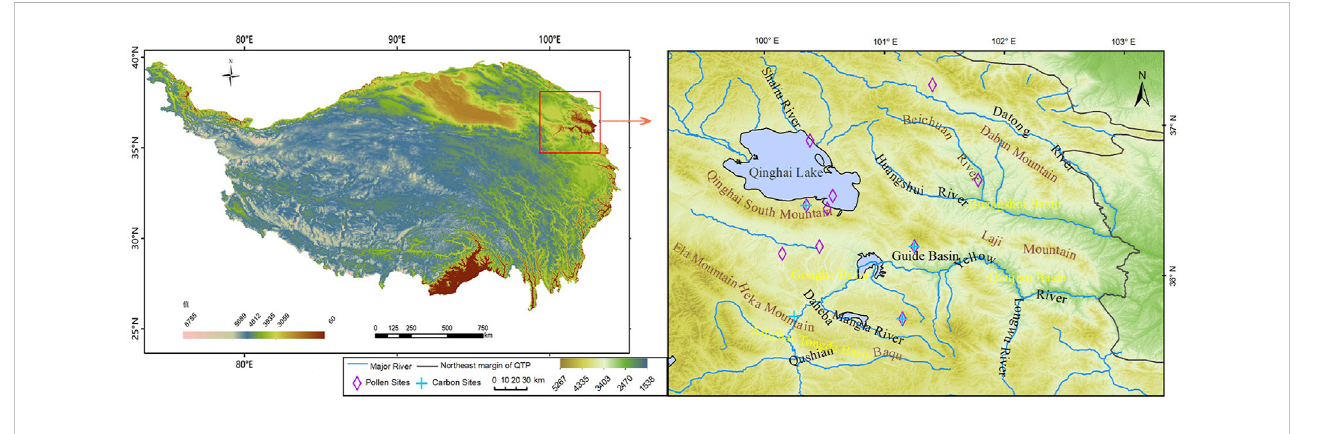
FIGURE 1 Study area and the location of the pollen sites and carbon sites used in this